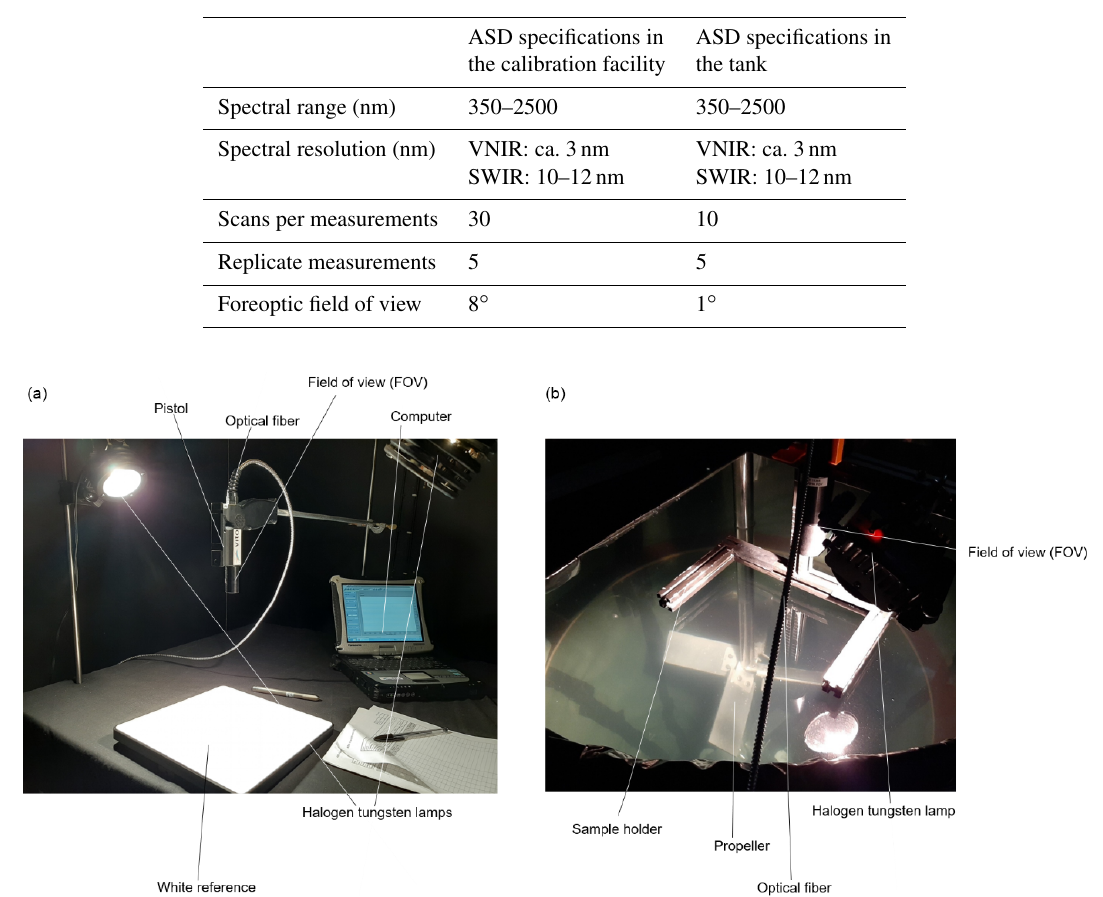
Table 3. Hyperspectral-radiometer specifications used in the two locations of the study: calibration facility and water silo tank. ASD: Analytical Spectral Device; VNIR: visible-near infrared; and SWIR: shortwave infrared.